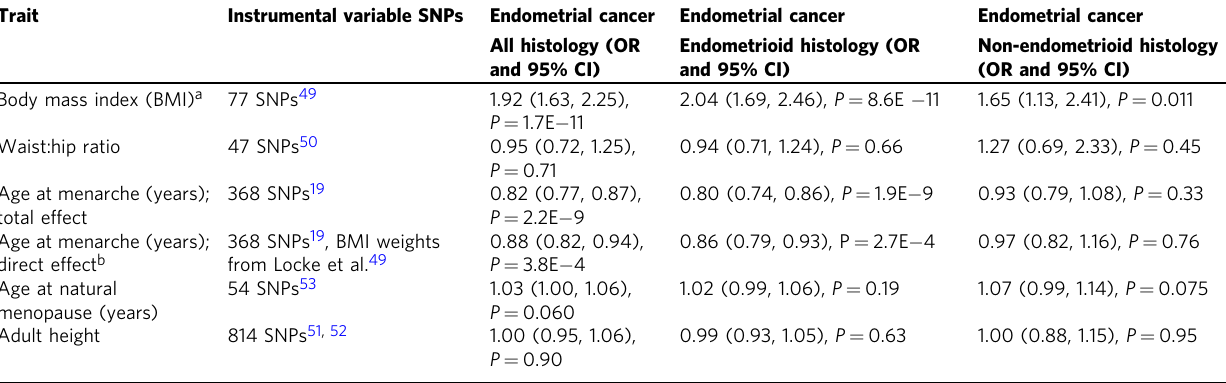
Table 3 Effects of genetically predicted anthropometric and reproductive traits on risk of endometrial